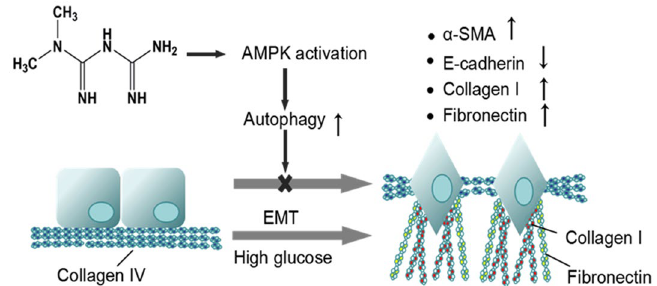
Scheme 1. Metformin blocks the epithelial changes associated with partial EMT. Normal epithelial cells show strong cell–cell adhesion and have a basal matrix consisting primarily of type IV collagen and laminin (left). Upon induction of partial EMT under high glucose condition, the cells lose their adhesion and change morphology (right). These cells cleave and invade the basal lamina, followed migrating along a newly formed matrix containing fibronectin and type I collagen. The abundance of epithelial biomarker (E-cadherin) is reduced, while that of mesenchymal marker (α-SMA) is increased.